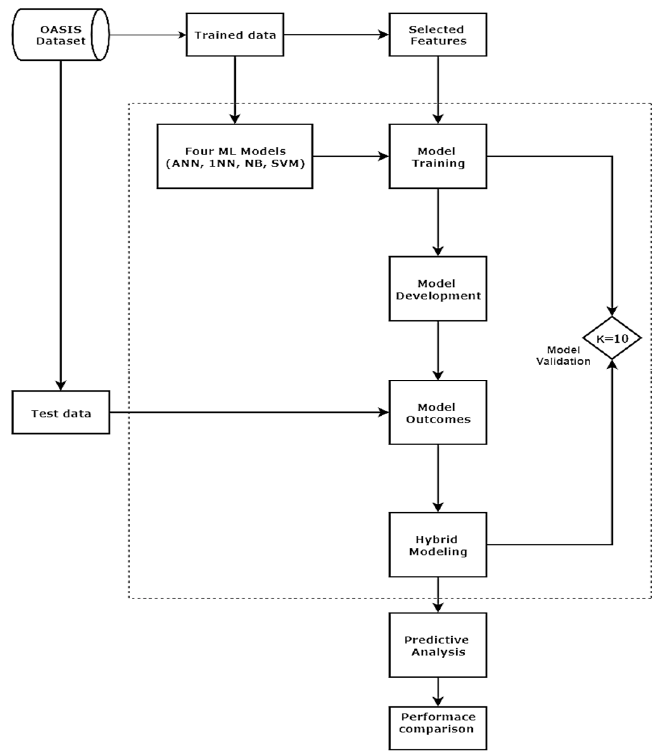
Figure 3. Model framework for evaluating predictive classifications.